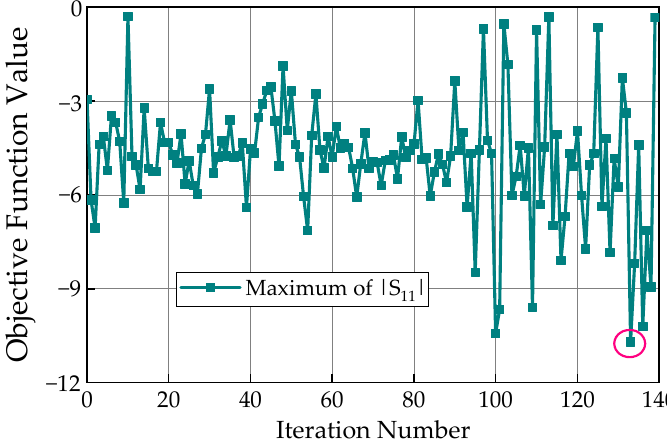
Figure 4. The convergence result for optimization based on the TPA. Red circle indicates the optimum sample.